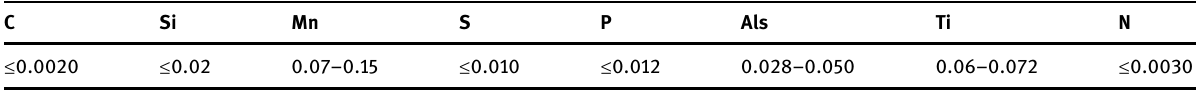
Table 2: Composition requirements of O5 automotive sheets ( % )